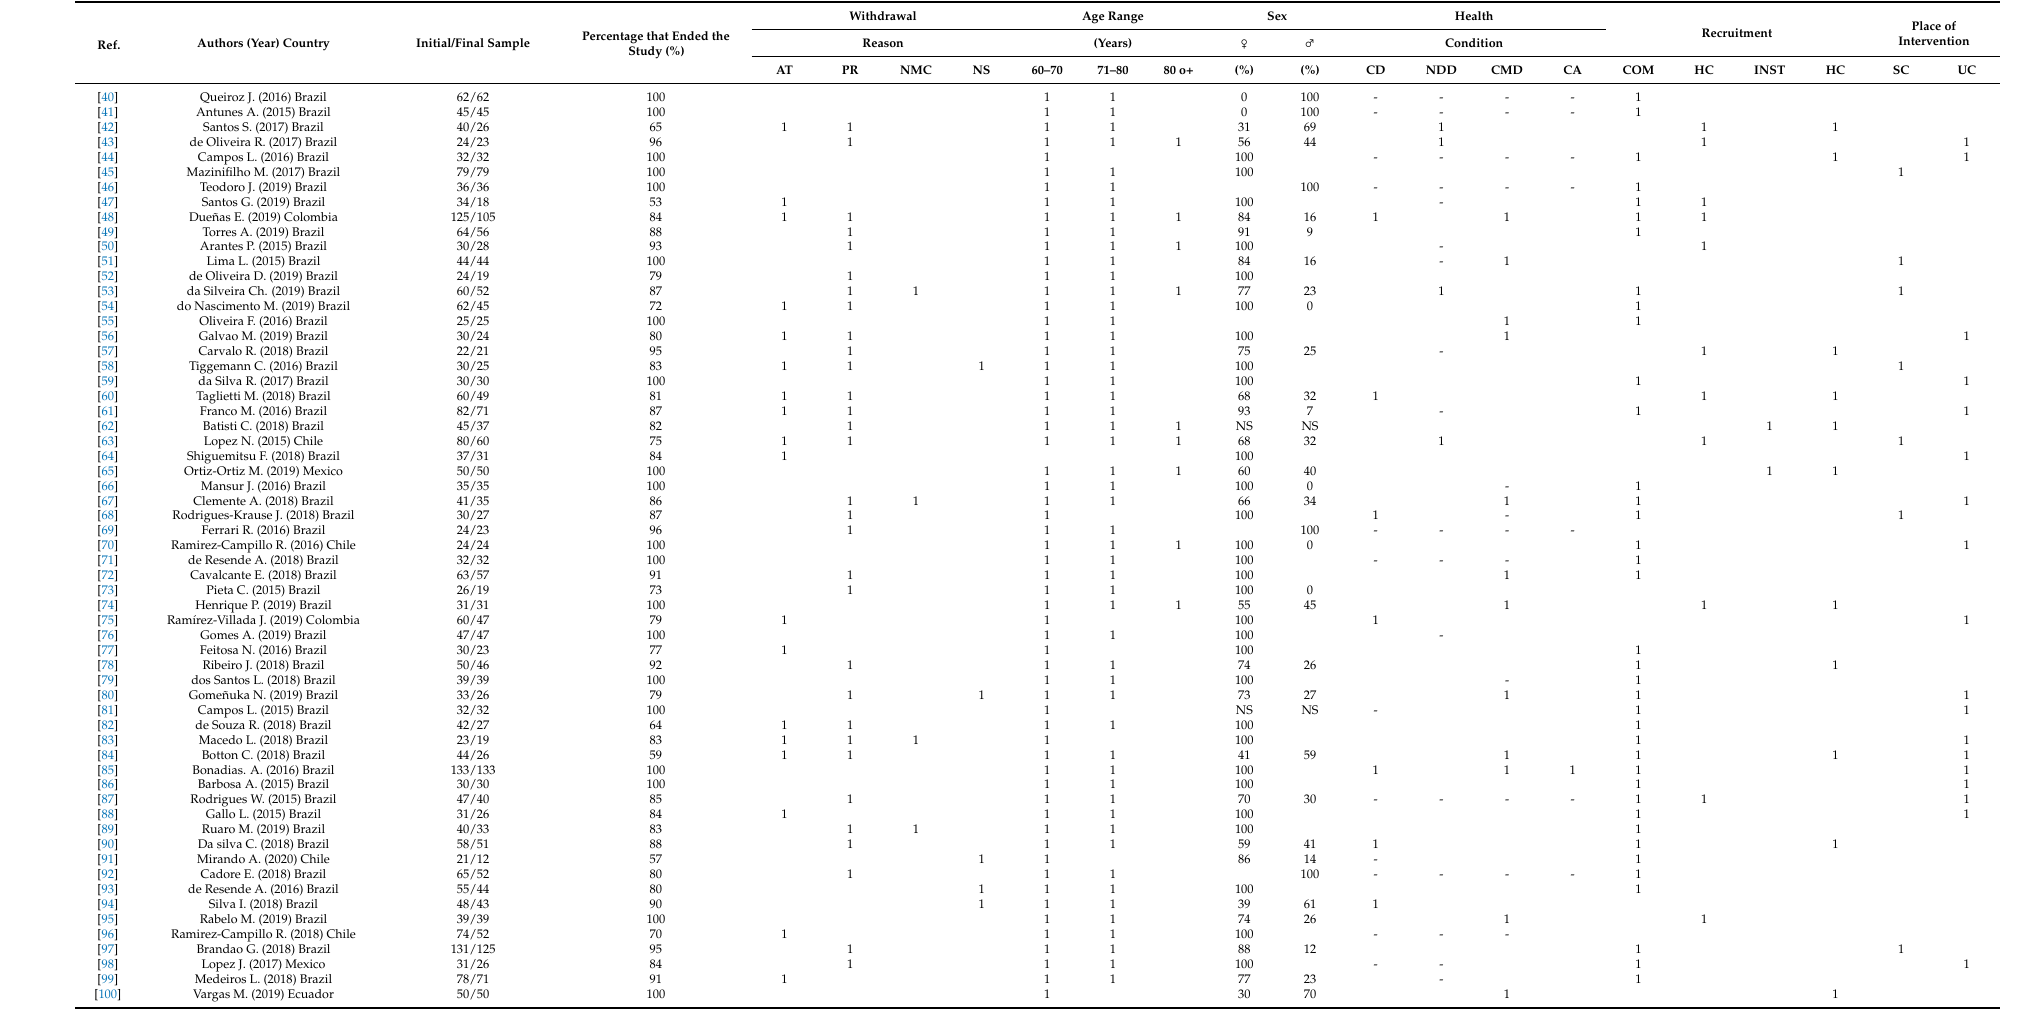
Table 2. Characteristics of the